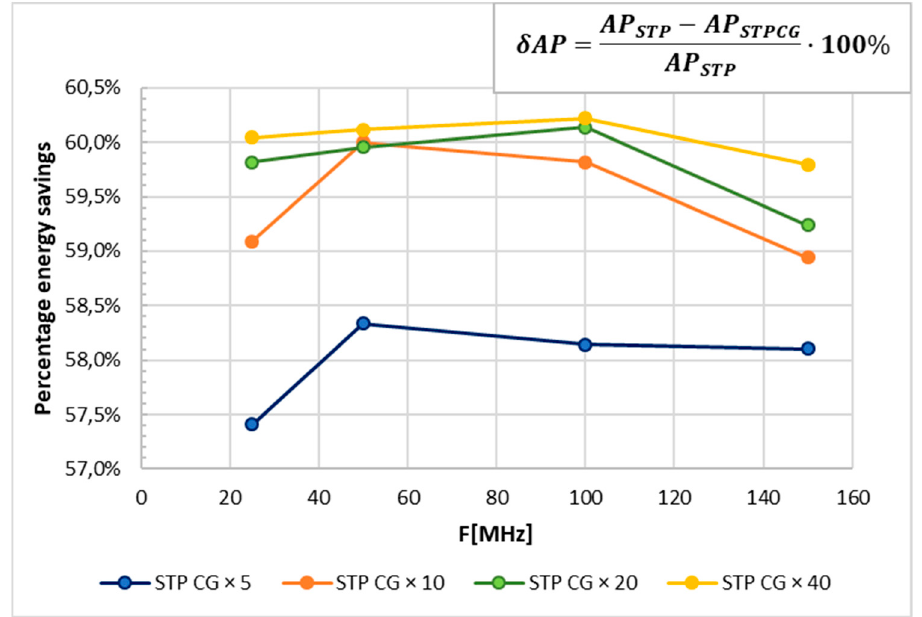
Figure 8. The average power savings per task for the architecture with a clock-gating mechanism compared with the appropriate STP structure for different frequencies.